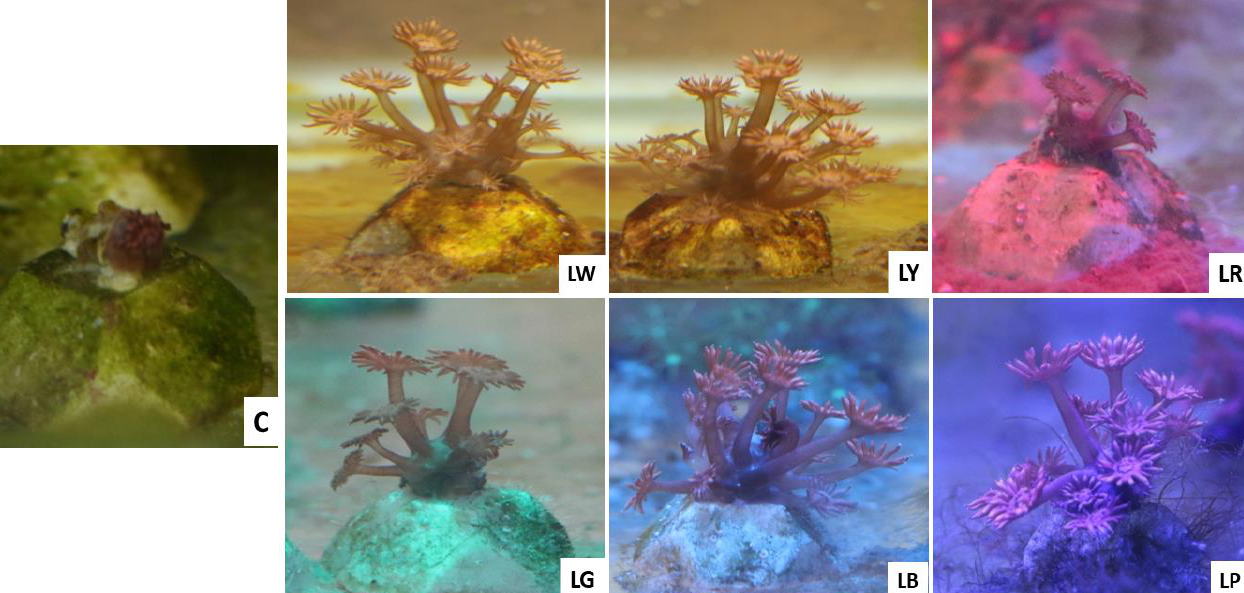
Figure 2. Photoacclimation of G. columna illuminated by various light sources. Goniopora columna specimens were exposed to LW (444 – 696 nm), LG (500 – 540 nm), LY (570 – 590 nm), LB (440 – 470 nm), LR (620 – 650 nm), or LP light (400 – 430 nm) for 30 min. The stretching and contractile behaviors of the polyps were captured using a Canon EOS 750D camera.